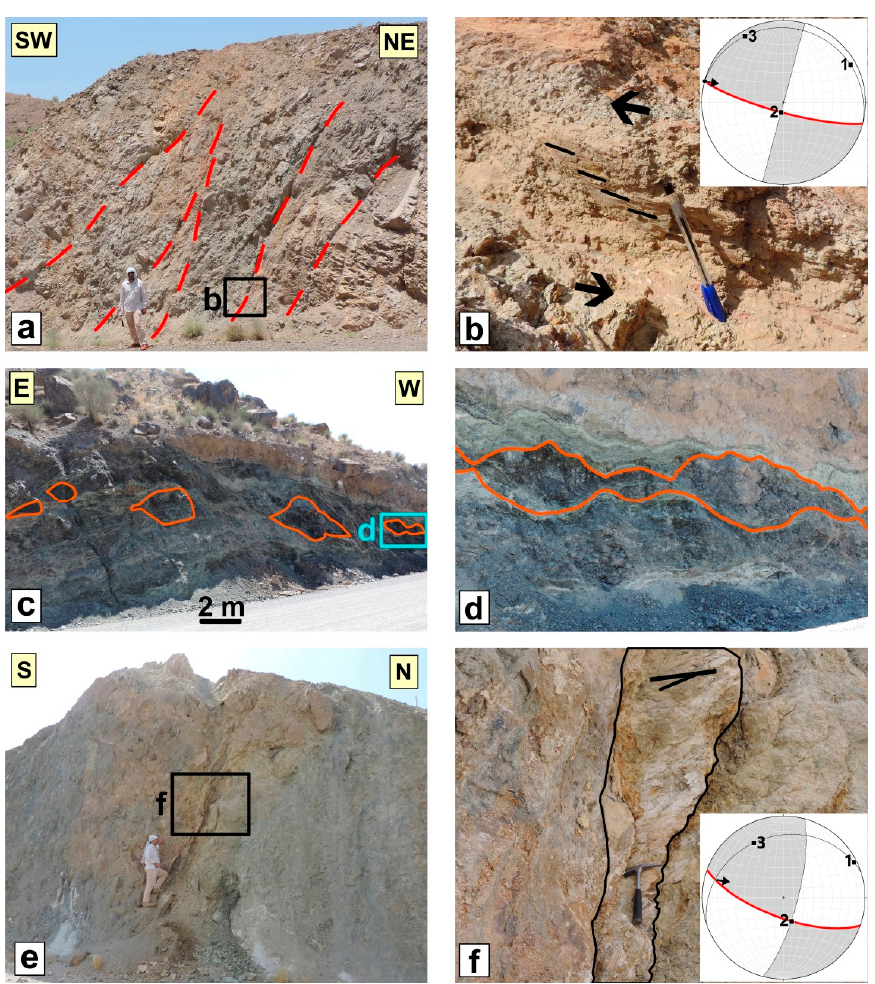
view of the fault plane (N60 ◦ W, 85 ◦ SW) and its striation (300 ◦ /05 ◦ ). The NW-SE South Birjand fault, with a length of ~50 km, is located in the Bagheran